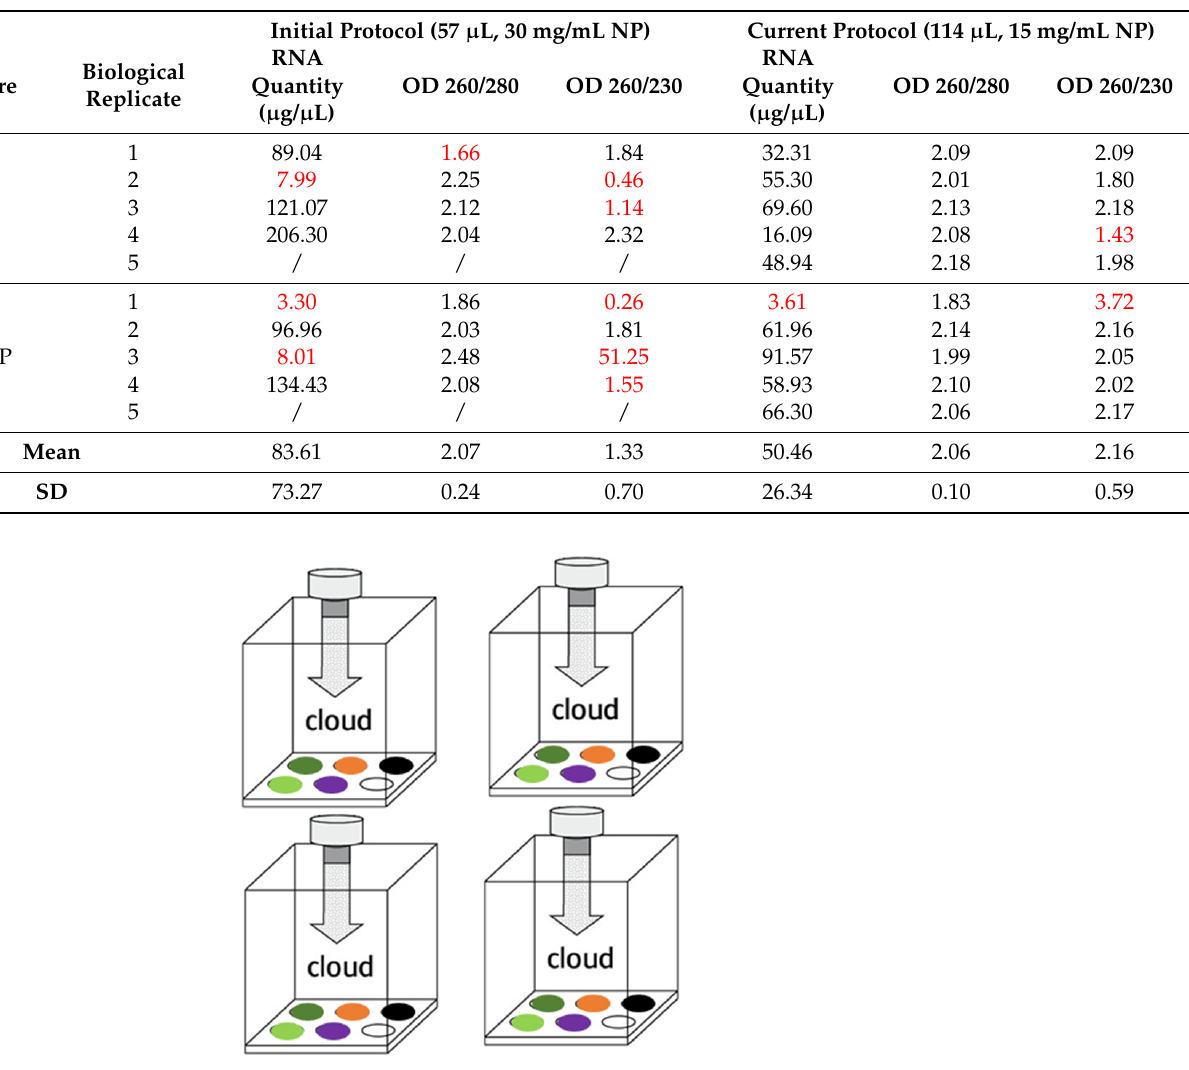
Figure 7. Methodology of NP exposure. One insert of each BR is placed in a well of the VITROCELL ® Cloud System for each of the NP exposures. After pooling of all TR, this ensures that all BR received an identical NP